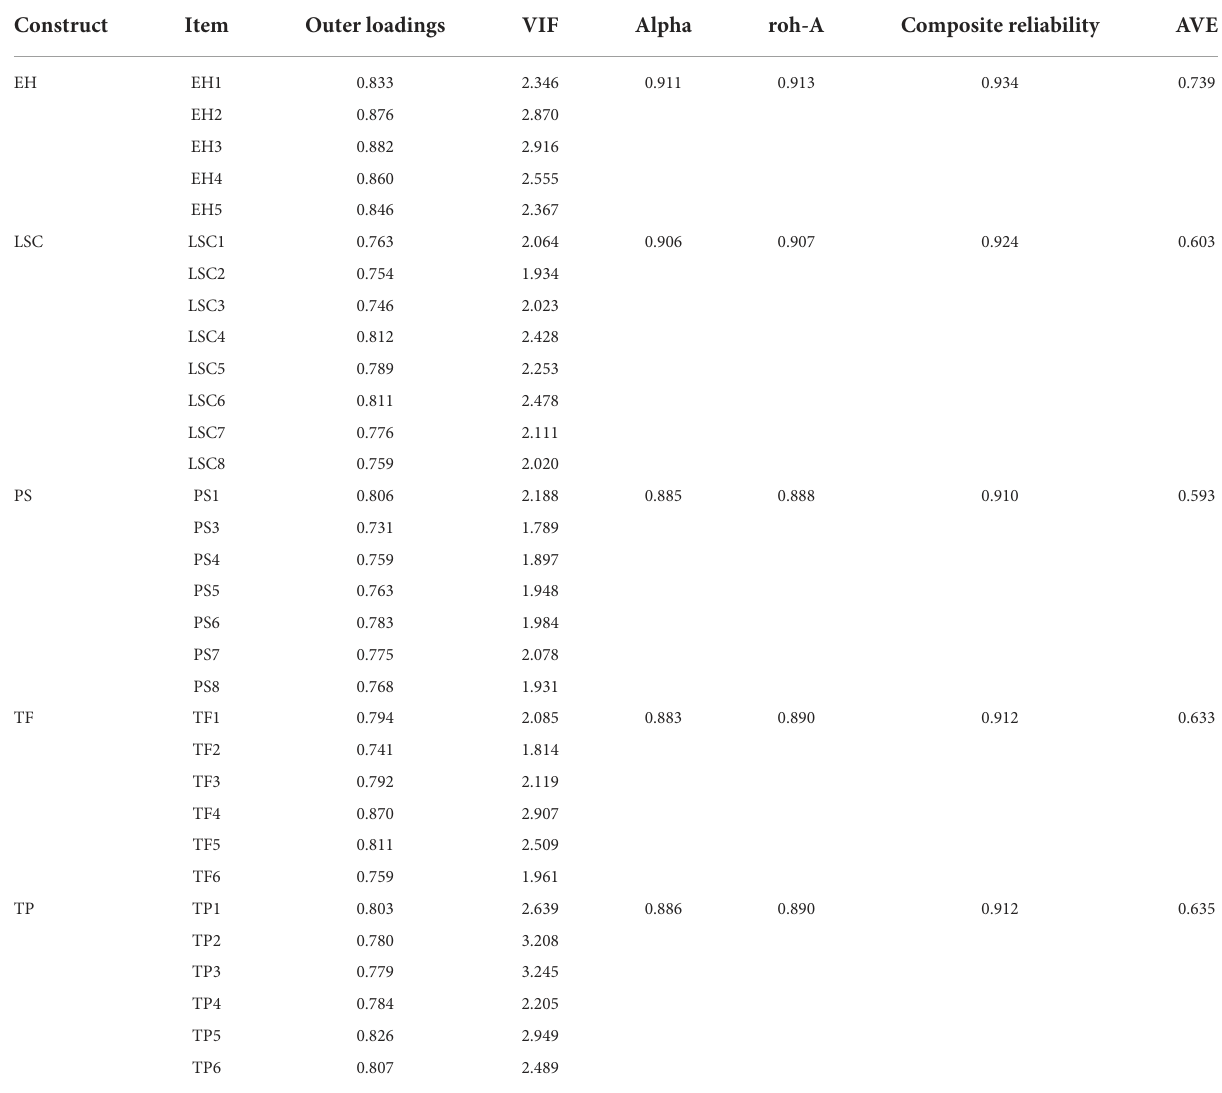
TABLE 1 Reliability and convergent validity of the study constructs.